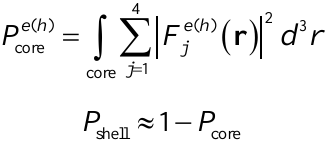
 , in the units of ||,